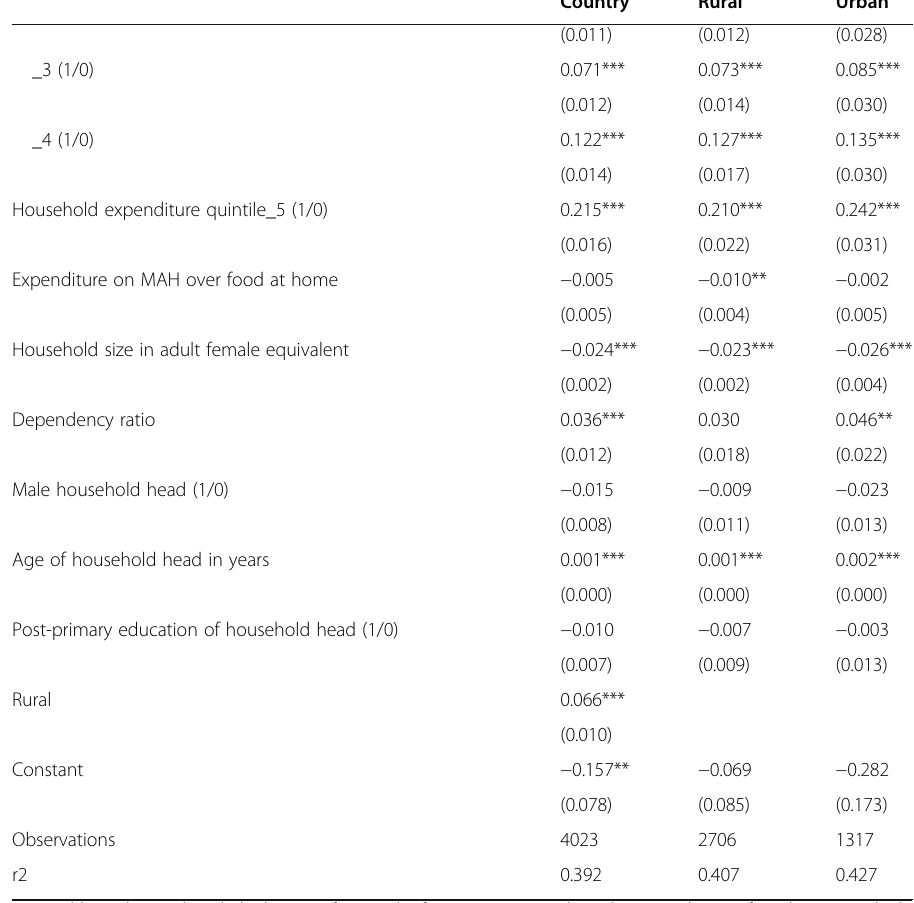
Table 3 The link between consumption of food group and household MPA